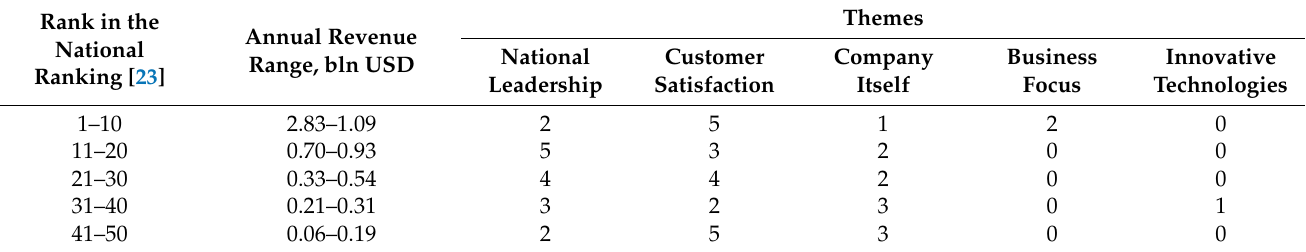
Table 1. General themes in the groups of agroholdings with different